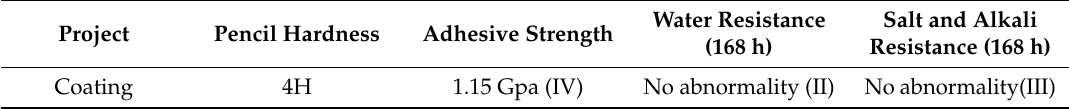
Table 2. Elementary properties and corrosion resistance of photocatalytic